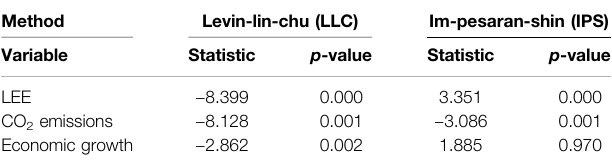
TABLE 2 | Panel unit-root test.